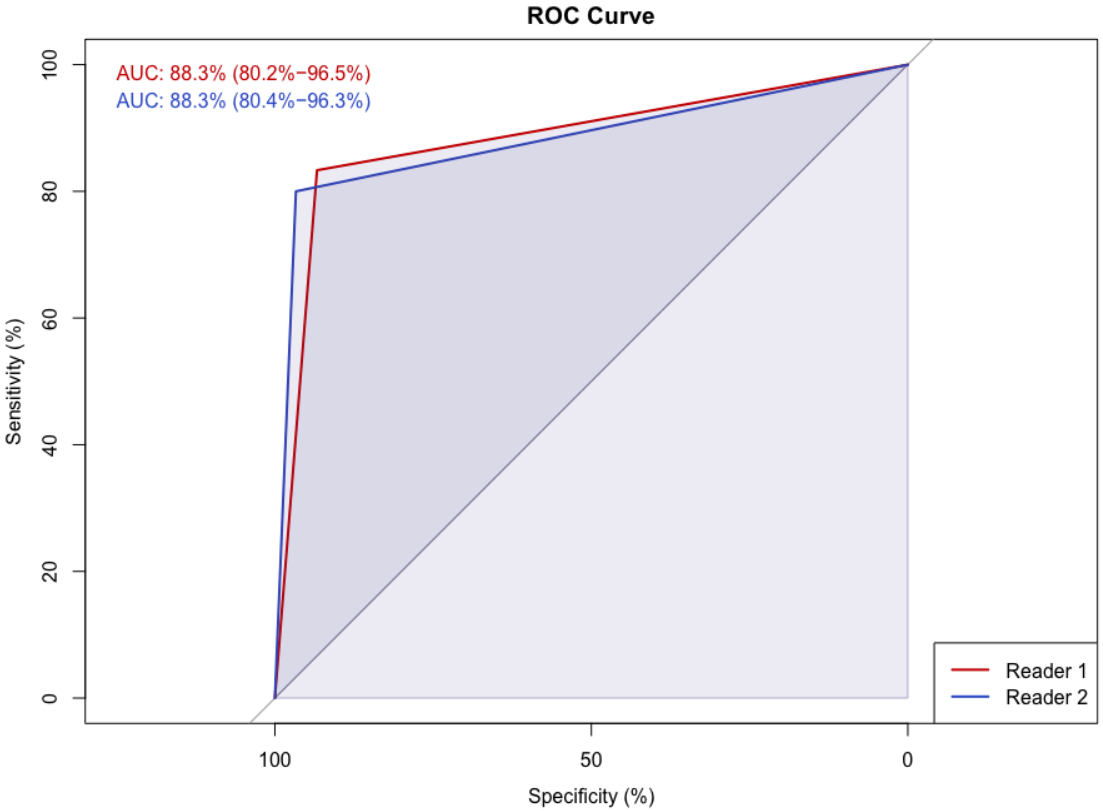
Figure 4. Receiver Operating Characteristics (ROC) Analysis for the Human Readout compared to the dCNN (Model 2) using a binary classification system: 0 = lower density (level A and B), 1 = high density (level C and D). Diagnostic Accuracy is expressed as the area under the curve (AUC).